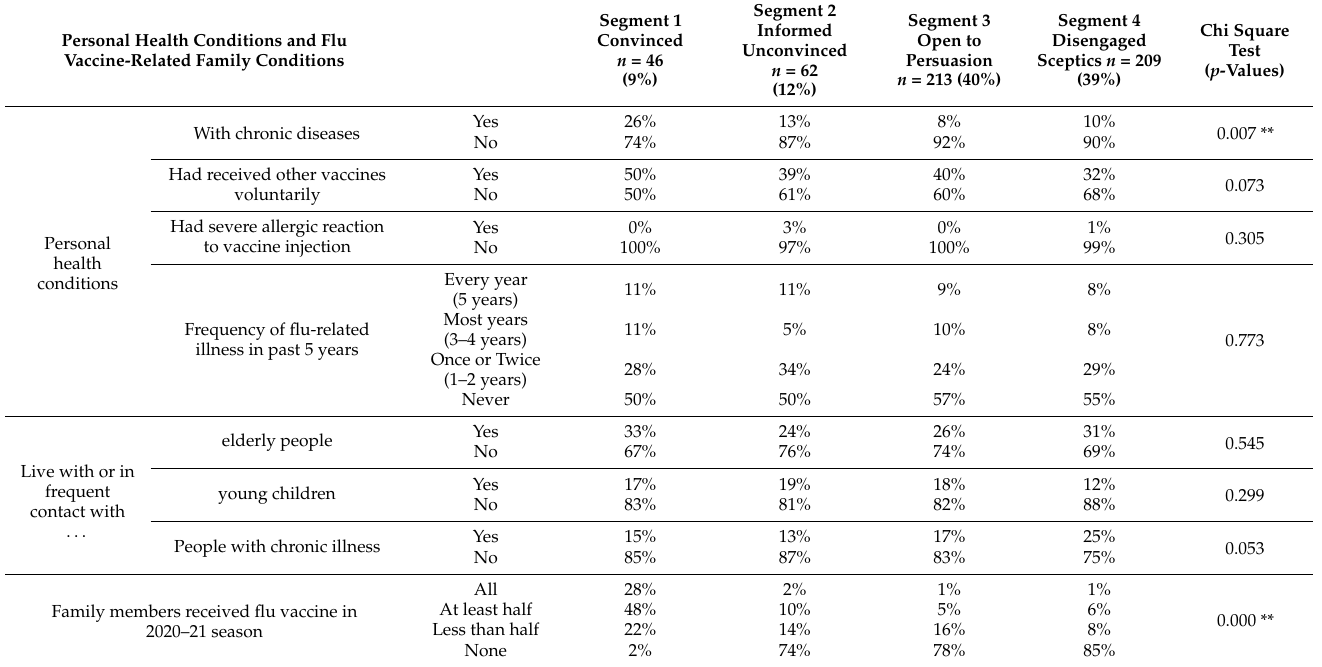
Table 4. Personal health conditions and flu vaccine-related family conditions by segment.